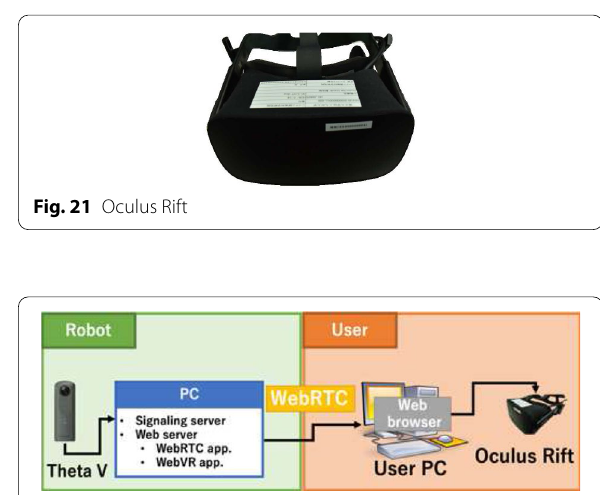
Fig. 22 Software configuration of the co-experience